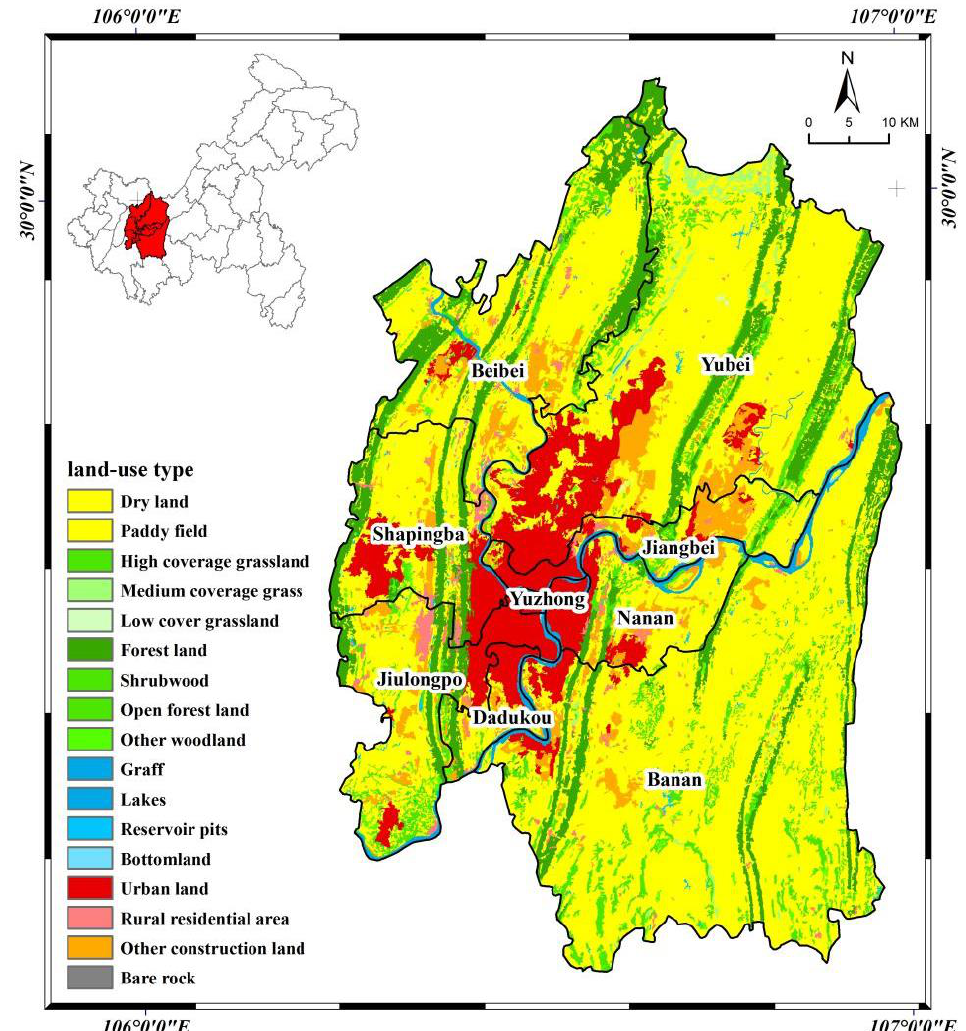
Figure 1. Location of the study area.